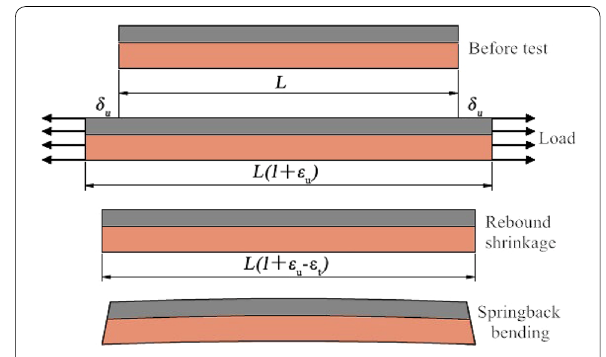
Fig. 6 Comparison of the bilinear model and experimental results